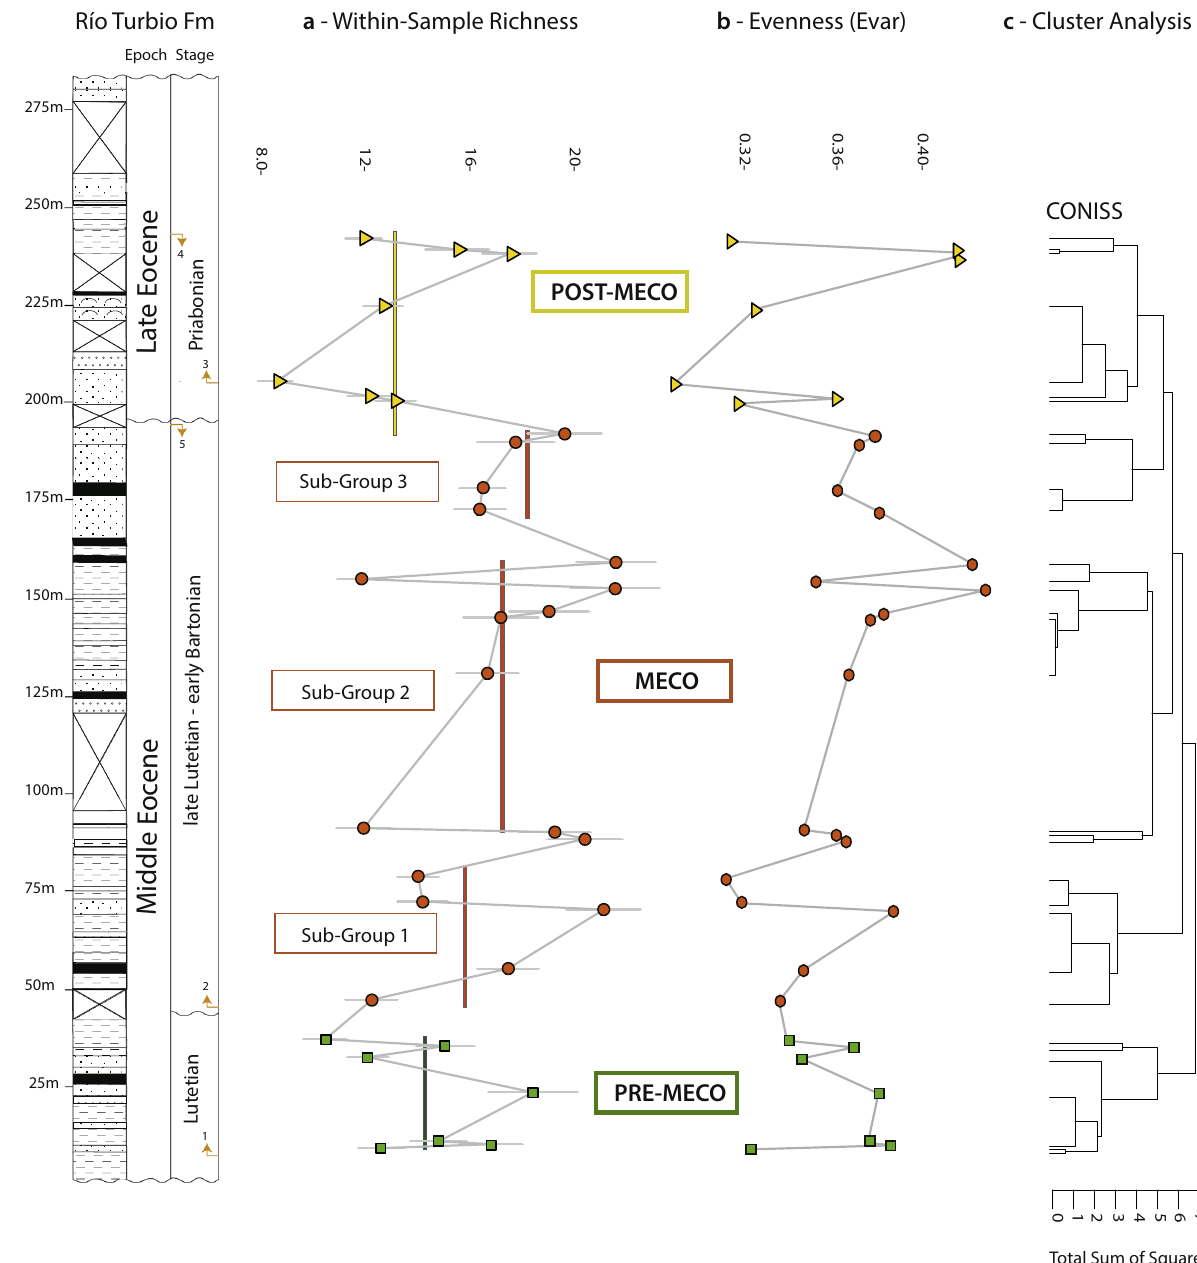
Fig. 2 Floristic diversity across time in southern Patagonia. a Within-sample richness (coverage level = 0.8) with bootstrapped 95% con fi dence intervals and b evenness for pre-MECO (green), MECO (dark-orange) with three subgroups and post-MECO (yellow) samples against the composite section of the Río Turbio Formation (see references in Supplementary Fig. 1). Vertical bars in a denote mean diversity within each major group of samples (or intervals) detected from the constrained cluster analysis ( c ). See Table 1 for further details. Arrows at the Stage column indicate major dinocyst events from the sampled composite section of the Río Turbio Formation; (1) Lowest Occurrence of E. dictyostila ; (2) Lowest Common Occurrence of E. dictyostila ; (3) Lowest Common Occurrence of T. fi losa ; (4) Highest Occurrence of T. fi losa ; (5) Highest Common Occurrence of E. dictyostila . See Supplementary Fig. 5 for further